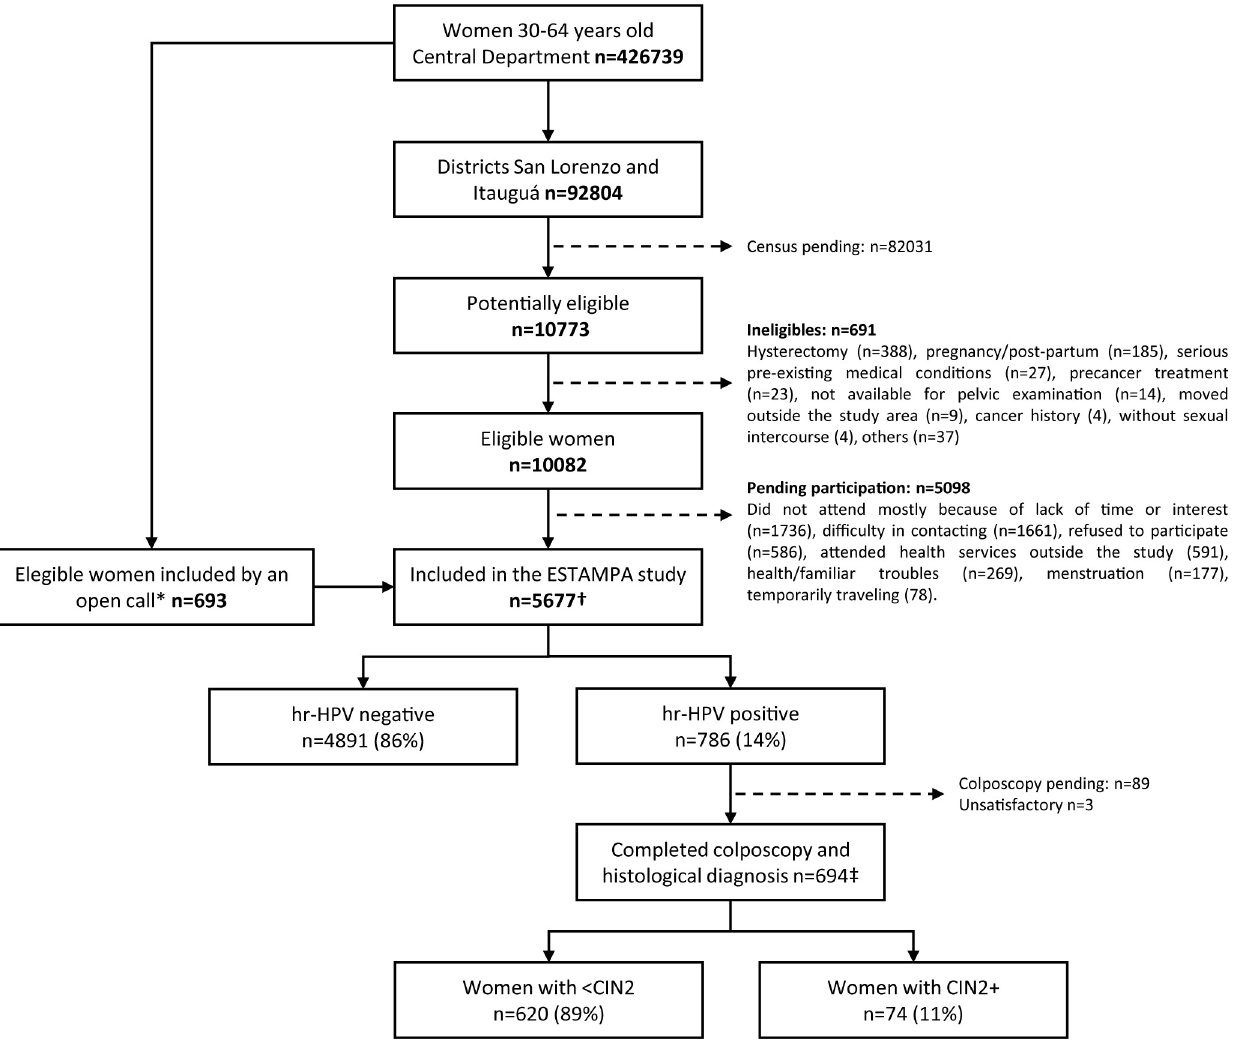
Fig 2. Flow diagram of participants. � Added participants enrolled by invitations (posters, talks) at the Universidad Nacional de Asuncio´n, Paraguay. †Women included in the analysis for the first outcome: hrHPV status and associated risk factors. ‡Women included in the analysis for the second outcome: presence of CIN2+ and associated risk